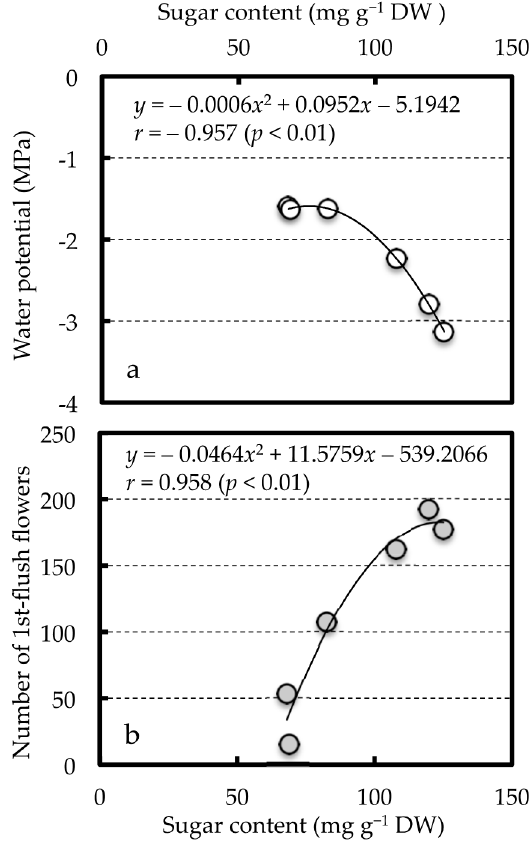
Figure 3. Relations between sugar content of the current shoot and the water potential of current leaves ( a ) or the number of first-flush flowers ( b ). The number of first-flush flowers indicates the number of flowers that opened in 10 current spring shoots per tree.